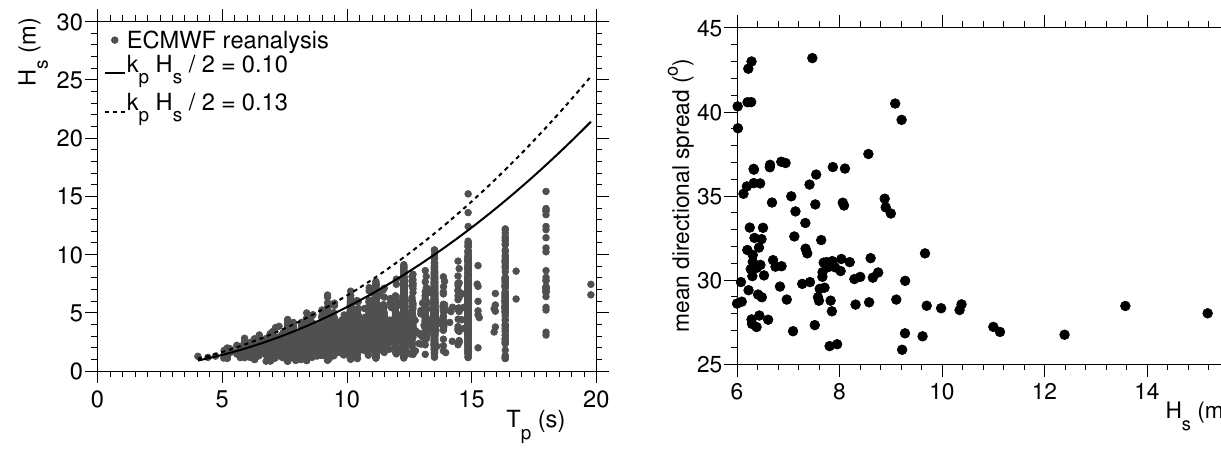
Fig. 5. Scatter diagram of significant wave height ( H s ) and spectral peak period ( T p ) for total seas from ECMWF reanalysis archive; lines of constant spectral steepness ( k p H s / 2 = 0.10 and 0.13) are included.